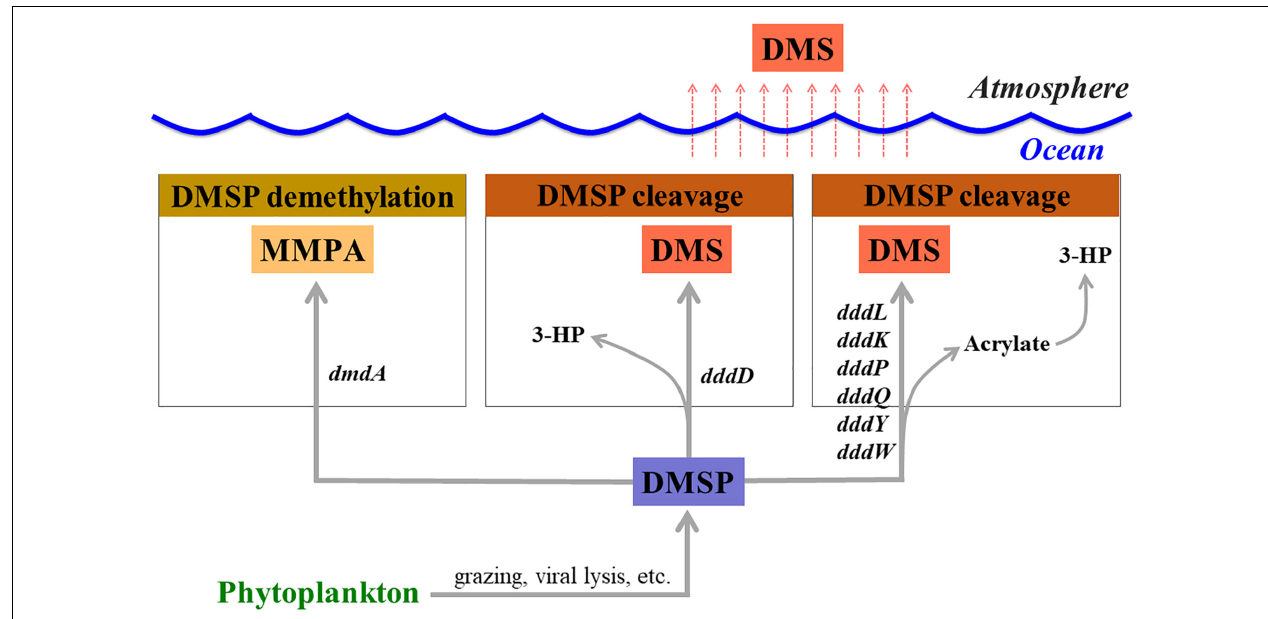
FIGURE 1 | Genes involved in dimethylsulfoniopropionate (DMSP) degradation and dimethyl sulfide (DMS) production. MMPA, methylmercaptopropionate; 3-HP, 3-hydroxypropionate.